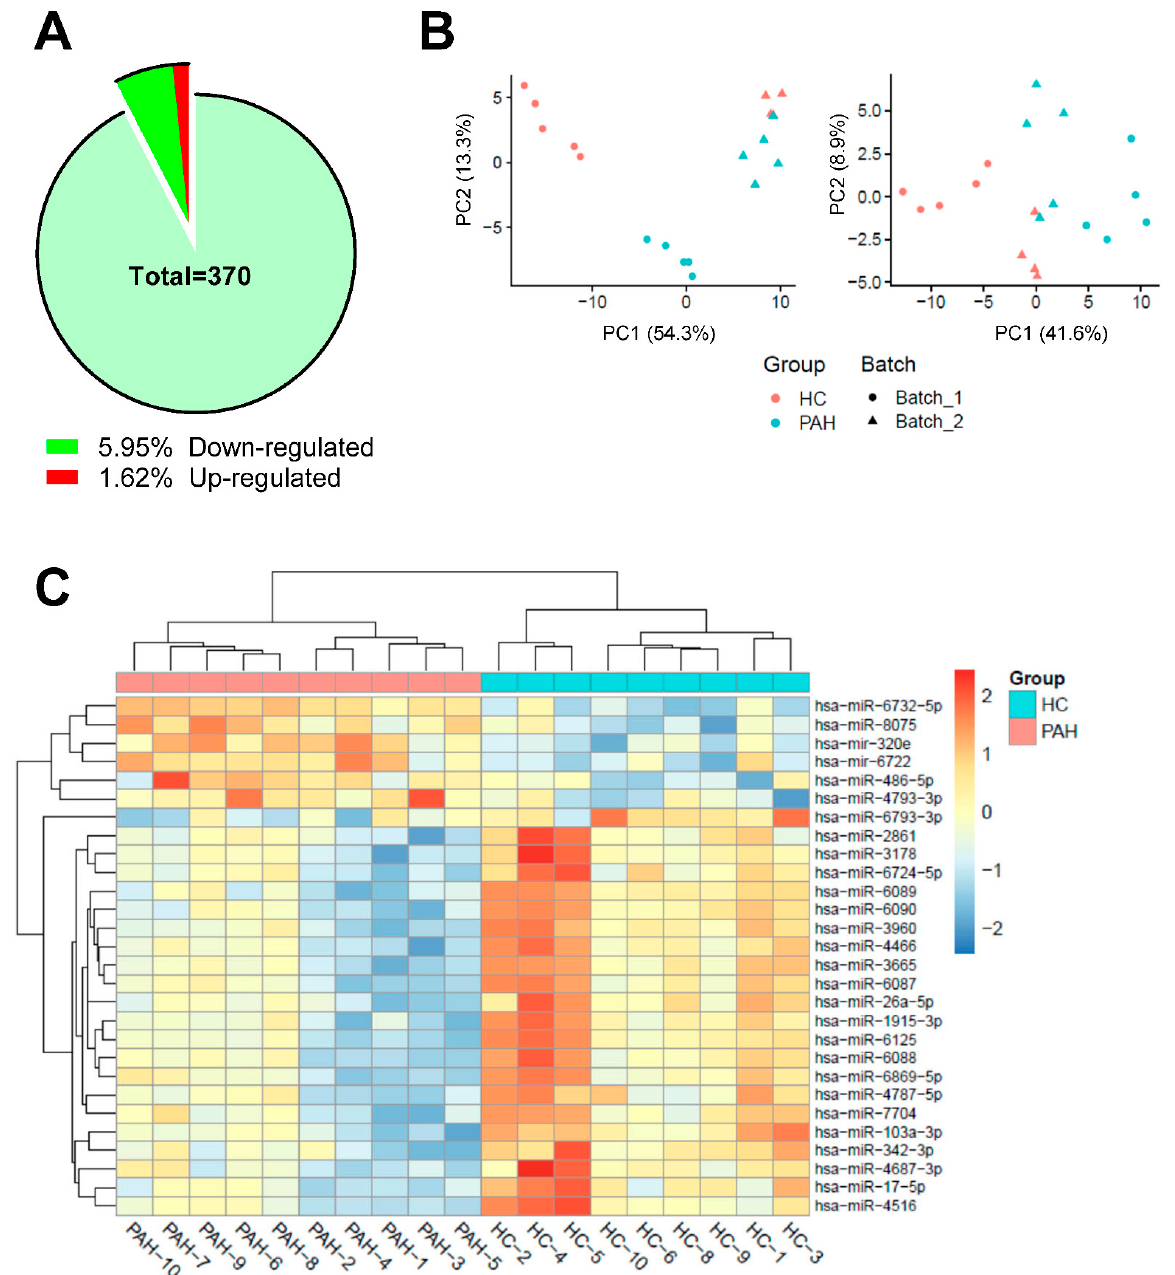
Figure 2. ( A ) Pie diagram depicting the distribution of total miRs and the differentially expressed miRs percentage in PAH EVs as against HC EVs ( n = 10 for PAH EVs and n = 9 for HC EVs). ( B ) Principal component analysis (PCA) before and after batch effect removal using Limma analysis. As depicted in the PCA, the HC (red) and PAH (blue) samples are separated from batch 1 (round) to batch 2 (triangle) ( C ) Heat map of miR microarray expression data from purified EVs of PAH patients ( n = 10) and HC ( n = 9). Sample miR species are shown to the right, and individual samples are at the bottom. The heat map depicts significantly different expression levels of miRs and their hierarchical relation among samples. Data is batch corrected, scaled, and centered where red indicates high expression of miR whilst blue indicates relatively lower expression of miR.